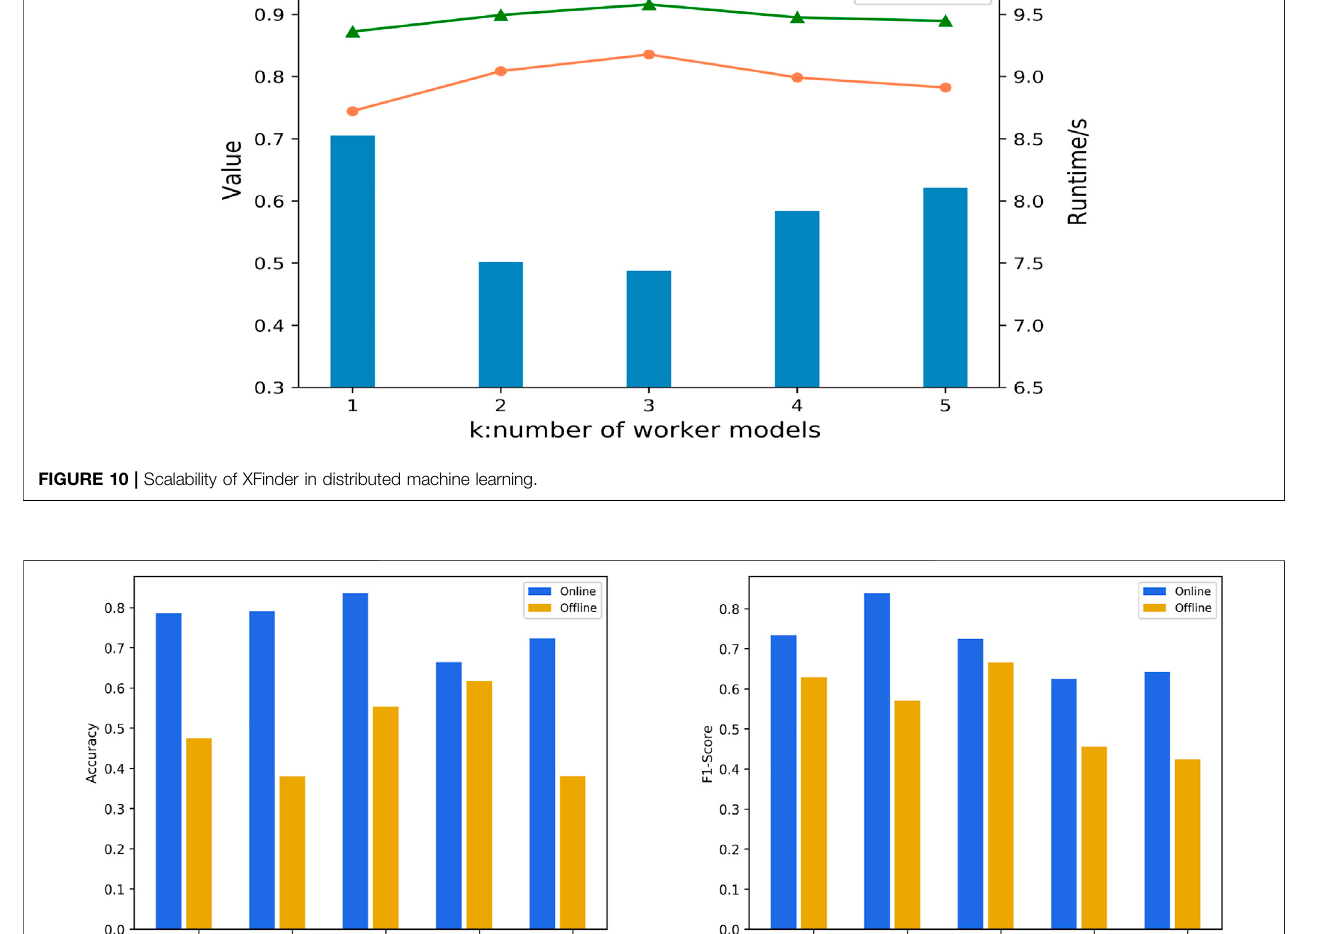
Frontiers in Computer Science |